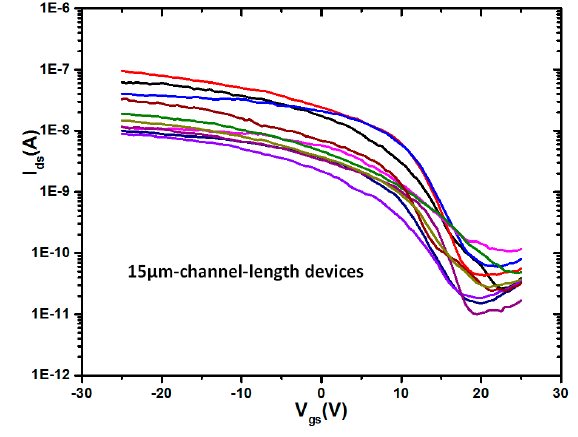
Figure 2. Transfer characteristic of ten as-fabricated SiNN FET with 15- μ m-channel-length .